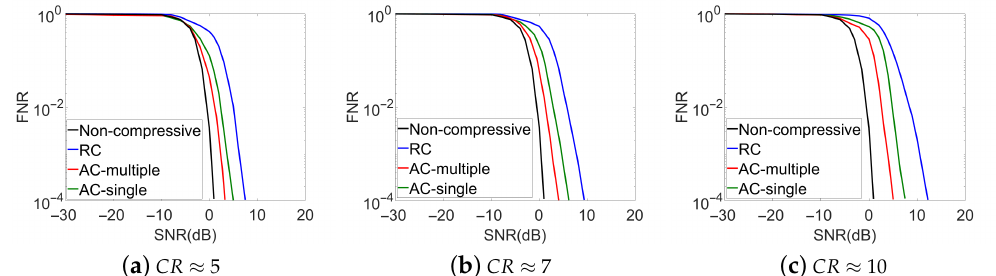
Figure 6. Simulated Detection Accuracies from Single Symbol-Period Measurements. (Non- compressive: Non-compressive detection method; RC: Conventional compressive detection with random measurement kernels; AC-multiple: Adaptive compressive detection with the multiple neural network strategy; AC-single: Adaptive compressive detection with the single neural net- work